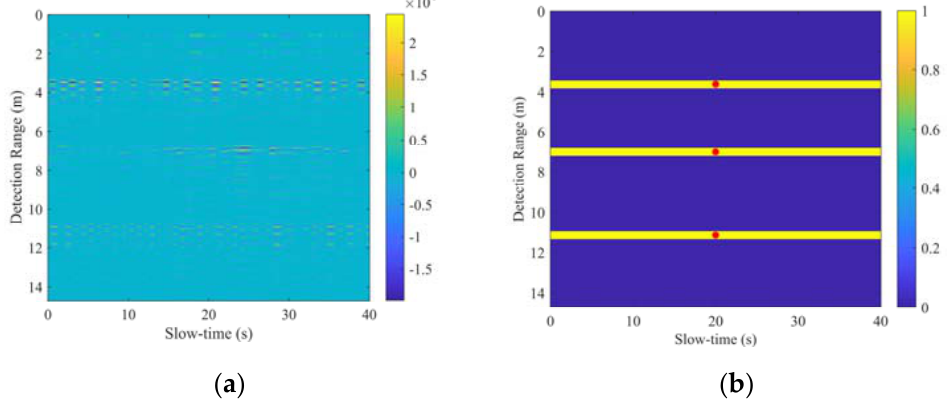
Figure 11. Results of the experiment with multiple targets: ( a ) range ‐ slow ‐ time matrix obtained after step A; ( b ) TPOIs extracted by CNN.